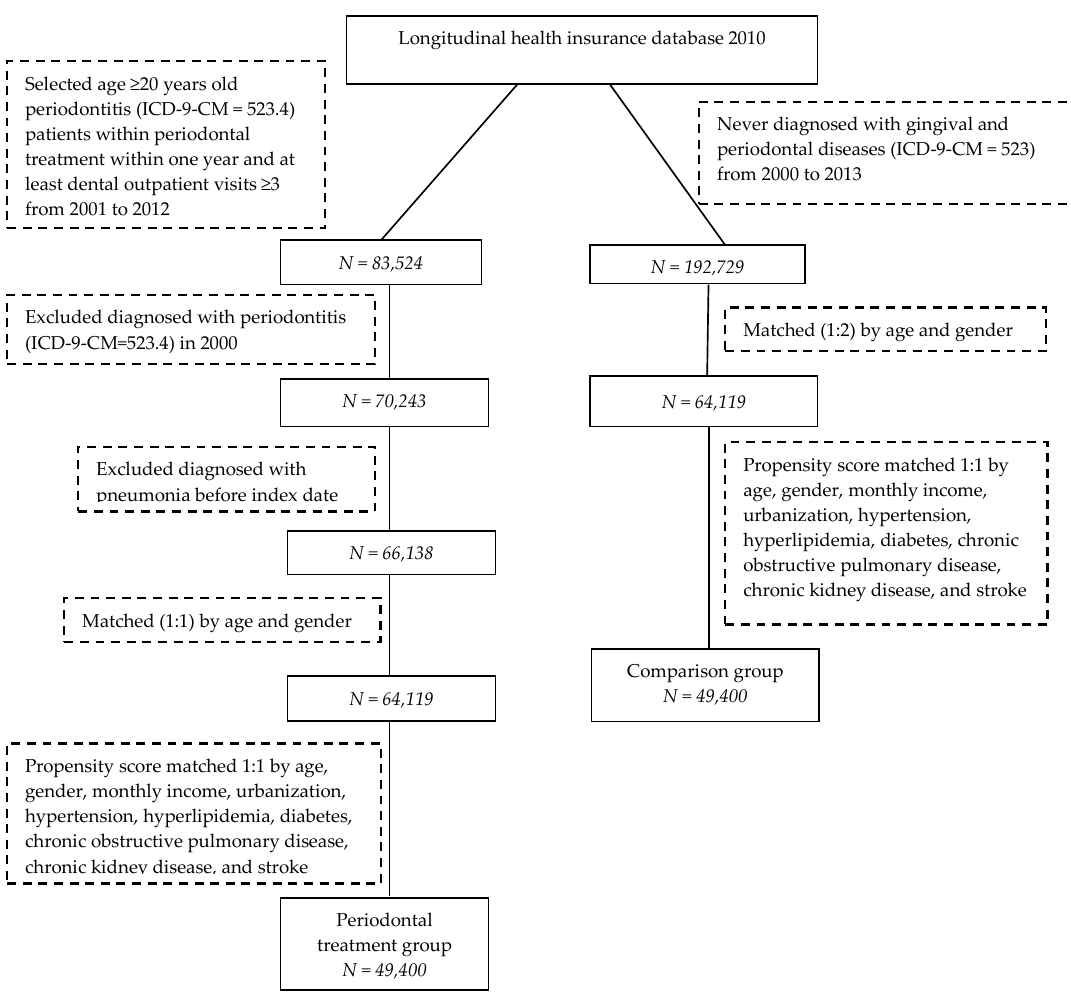
Figure 1. Flow diagram of patients’ enrollment in the study cohorts.